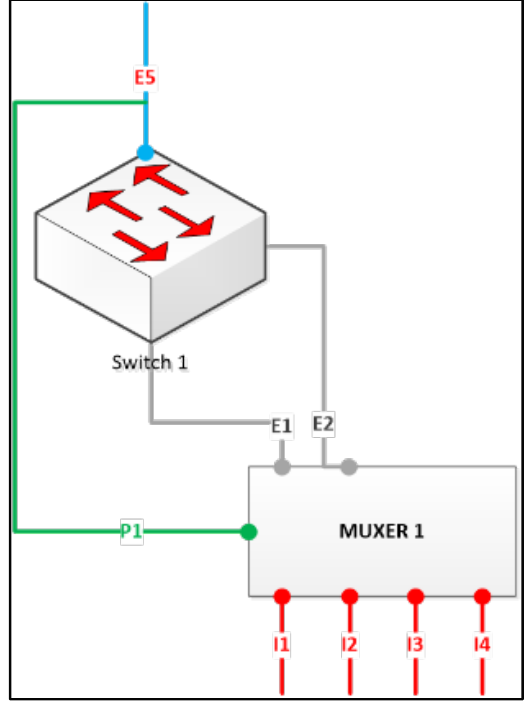
Figure 6. Mechanism of MUXER to turn off and turn on switch.